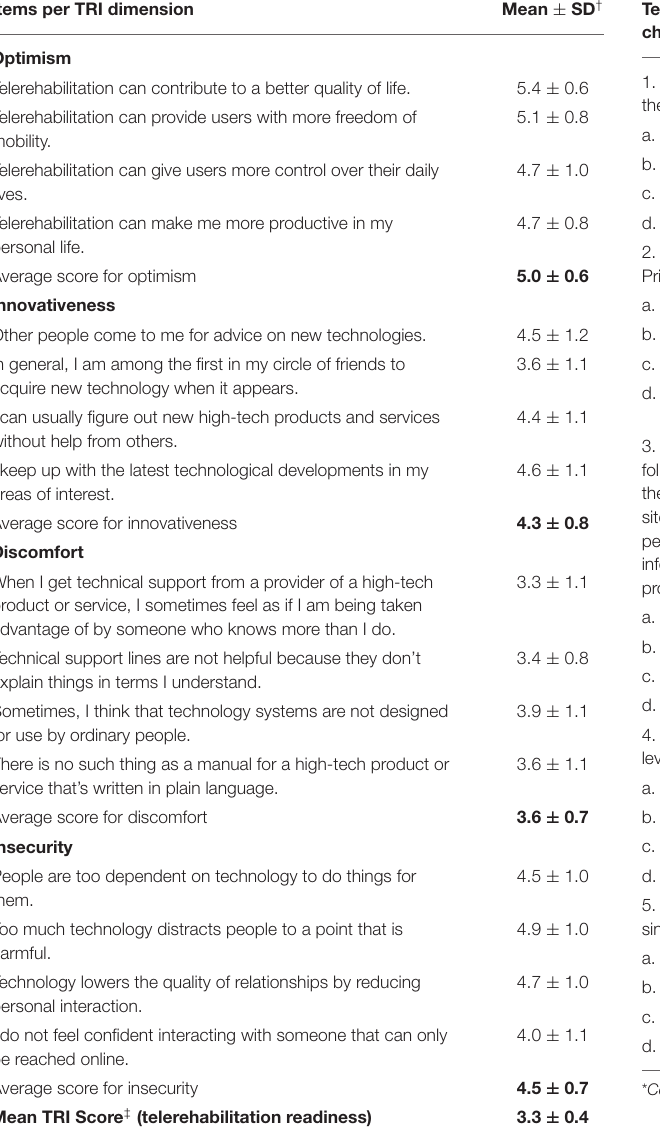
TABLE 3 | Tally of responses on the multiple-choice questions regarding telerehabilitation ( N = 62). Telerehabilitation knowledge questions and choices